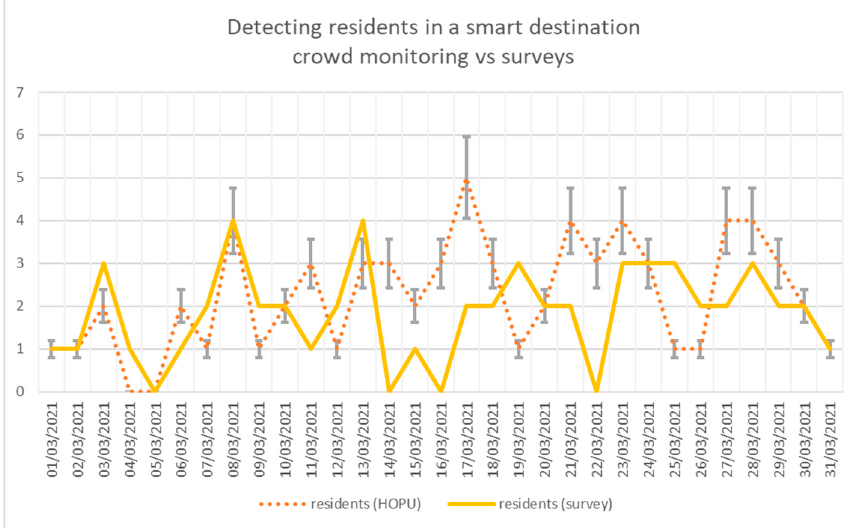
Figure 8. Using HOPU Smart Spot vs. manually conducted surveys to determine number of residents in Alcoi.